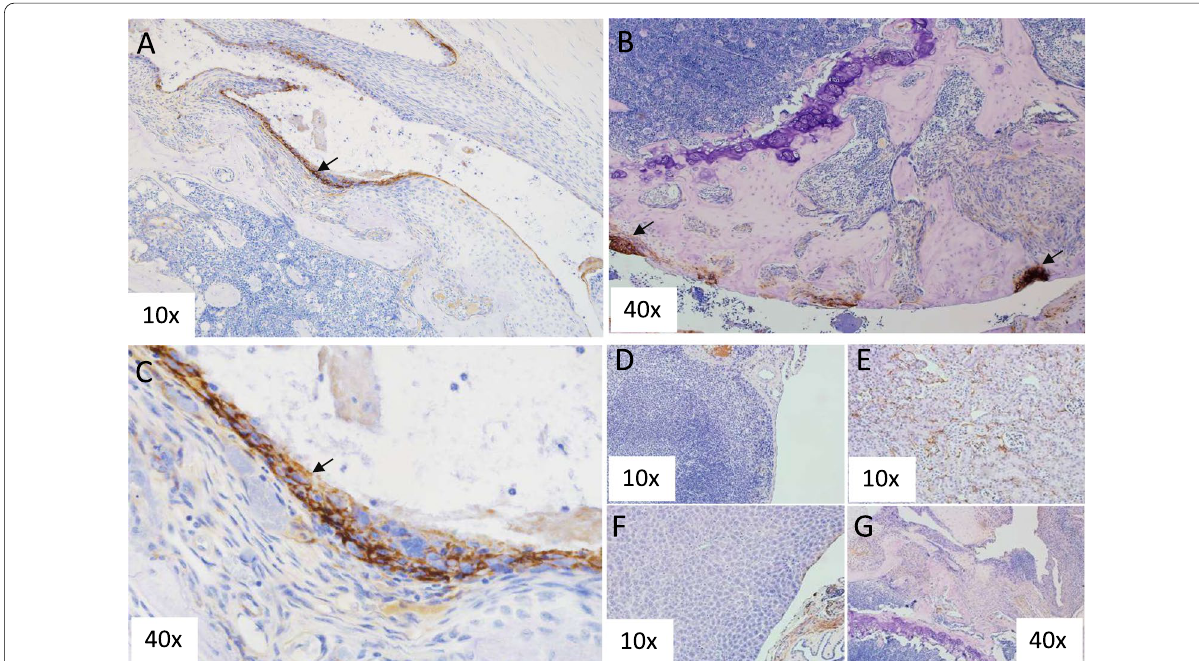
Fig. 2 Anti-FnEDA mAb biodistribution detected by anti-human IHC. Biodistribution into inflamed knee joints ( A – C ), contrasts with non-specific organs shown in spleen ( D ), kidney ( E ) and liver ( F ); inflamed joints from animal treated with isotype control anti-TeTx antibody ( G ). Arrows point to disease specific structures (N 3, Arrows in A and C point to inflamed synovium, arrows in B indicates focal erosion pits, magnification level is noted = in each picture)